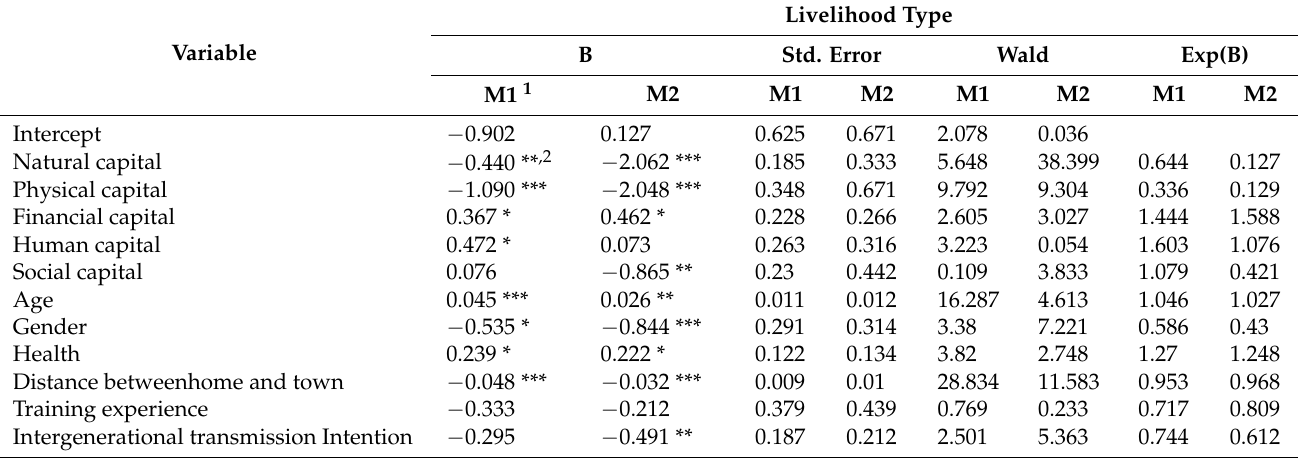
Table 3. Results of the impact of different types of livelihood capital on livelihood strategy.